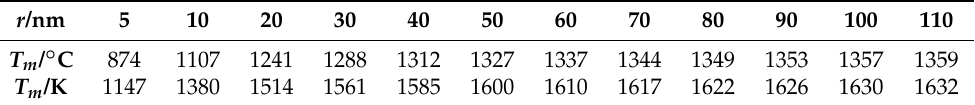
Table 3. The melting point of the titanium nanoparticles as a function of the particle size.